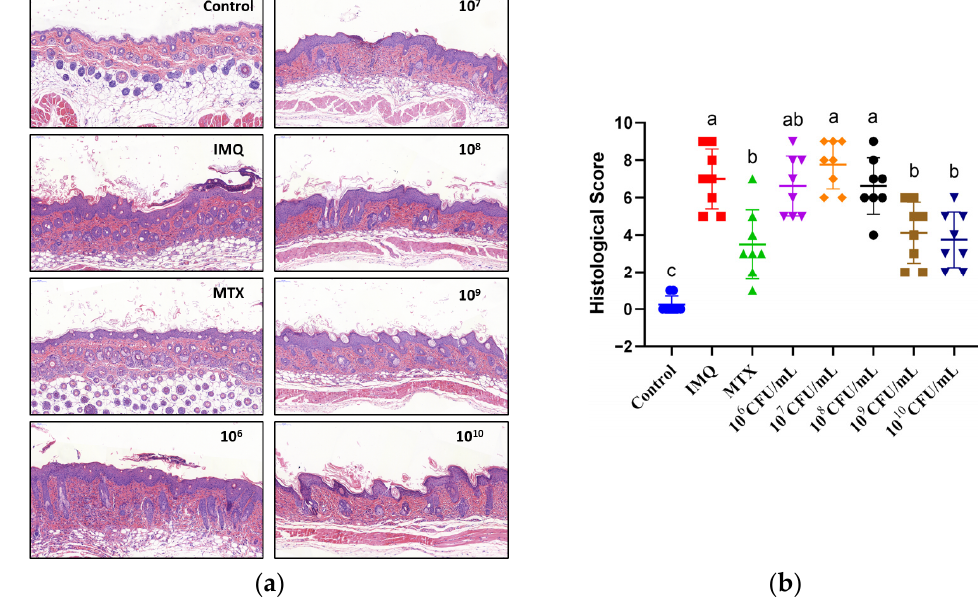
Figure 2. Effect of CCFM683 treatment on histological characteristics in psoriasis mice. ( a ) Cutaneous histology and ( b ) histological score of skin. n = 8 mice per group. Groups with different letters are significantly ( p < 0.05) different from each other.